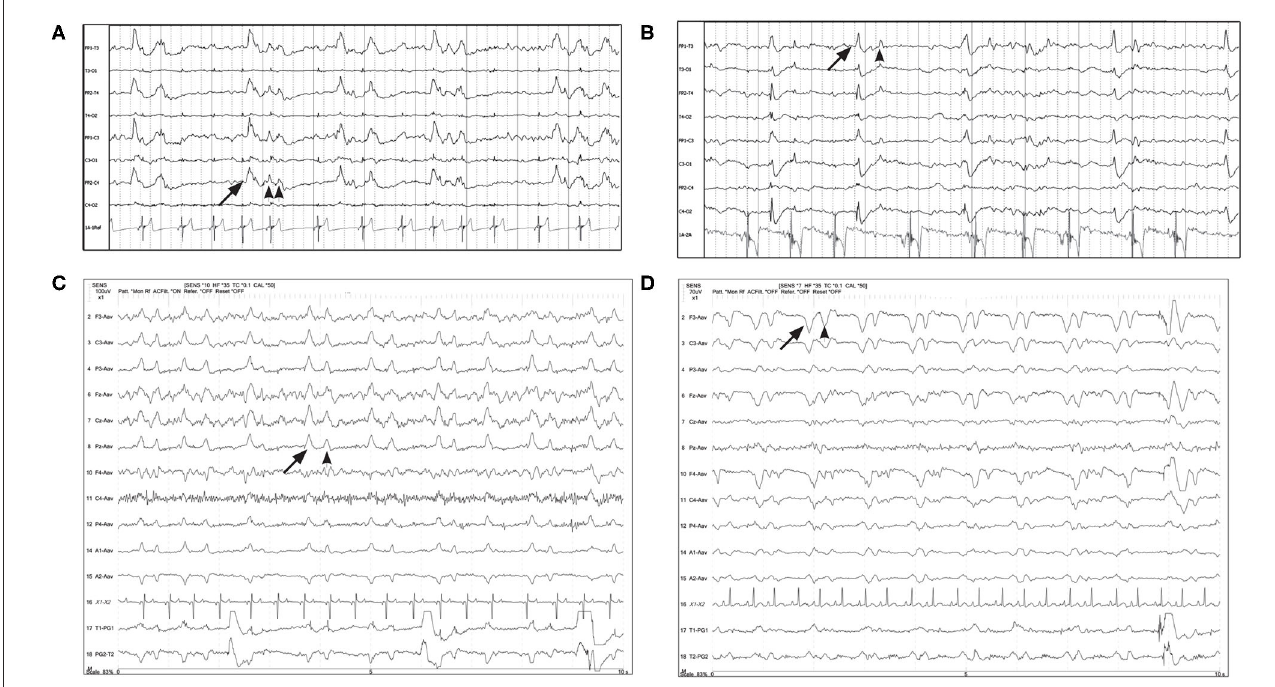
FIGURE3 Four examples of periodic discharges, where the morphology of the PD (solid arrow) included a second or third waveform (arrowheads), with a consistent temporal relationship to the initial discharge, like a doublet or triplet. (A) Eleven year old Chihuahua with SE (Bipolar montage; HF 70Hz, sensitivity 20 uV/mm). (B) Two year old bichon mix with progressive partial seizures and MUO (Bipolar montage; HF 70Hz, sensitivity 10 uV/mm). (C) Three year old terrier mix with cluster seizures, normal brain MRI, likely idiopathic epilepsy (Referential montage; HF 35Hz, sensitivity 10 uV/mm). (D) Five year old Basset hound presented with heat stroke, stuporous, multiple organ dysfunction, no seizures documented (Referential montage; HF 35Hz, sensitivity 7